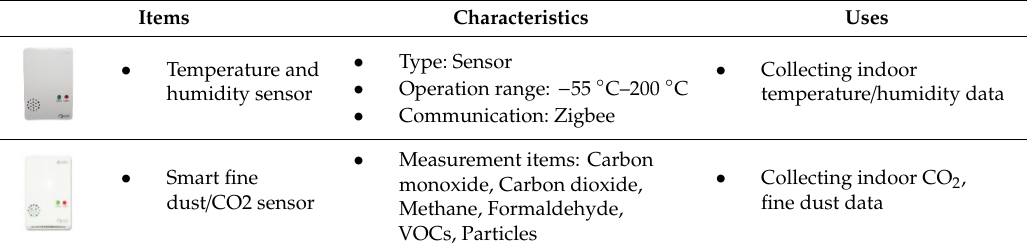
Table 4. Specifications of installed sensors.